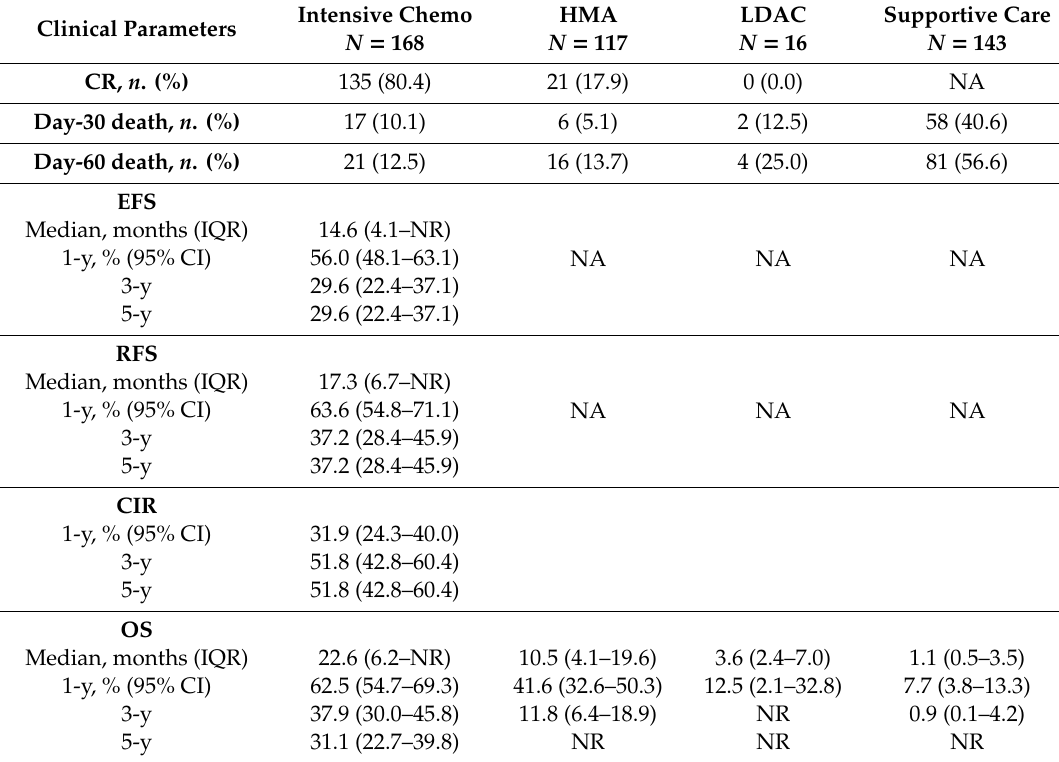
Table 2. Responses and outcomes according to first-line treatments.